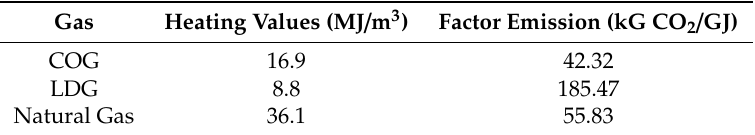
Table 7. Heating values of steel gas cogeneration.